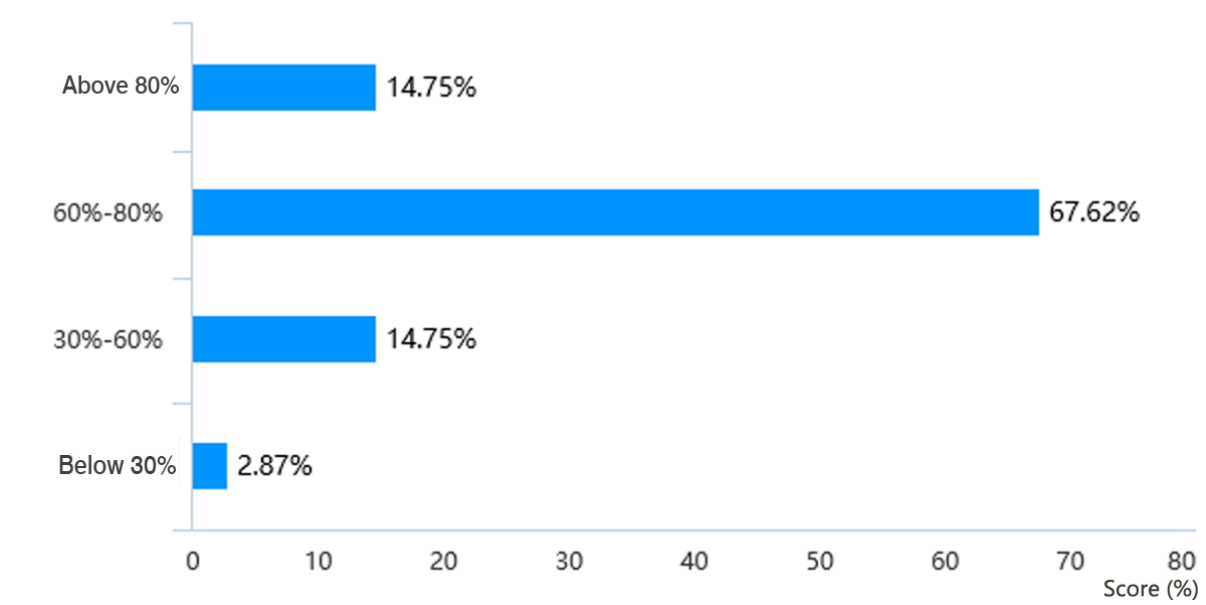
Figure 5. Scores showing the extent of students’understanding and mastery of the theoretical knowledge of histology and embryology through web-based learning.